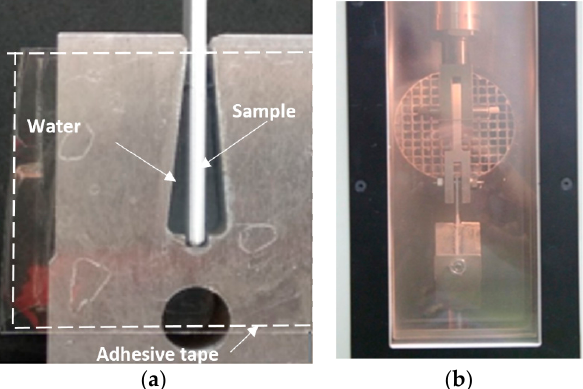
Figure 4. Test block employed to form ice on both sides of the sample ( a ) and block attached to the Universal Machine ready to start the test ( b